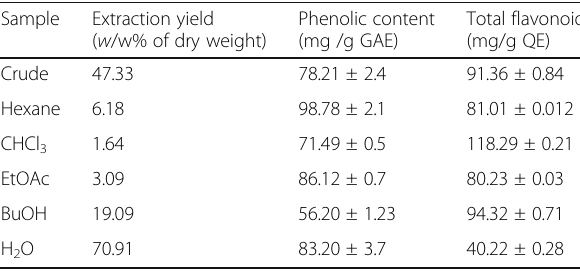
Table 2 Yield percentages, Total phenolic and flavonoid contents of ethanolic extract and solvent fractions of S.